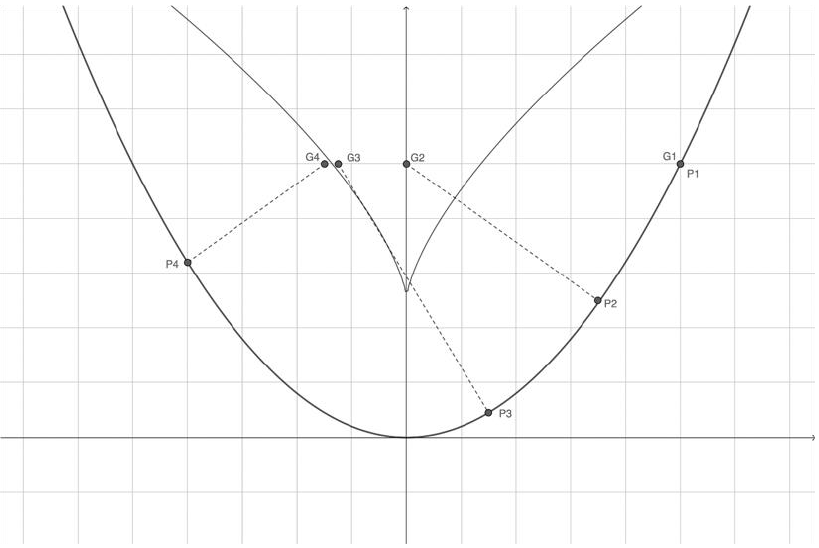
Figure 5. Machine